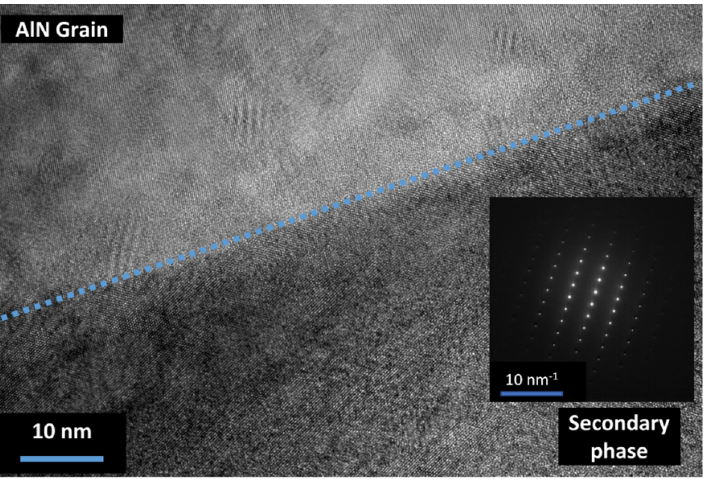
Figure 10. Observation by TEM of a grain boundary of AlN + 3 wt.% CeO 2 sintered by SPS.